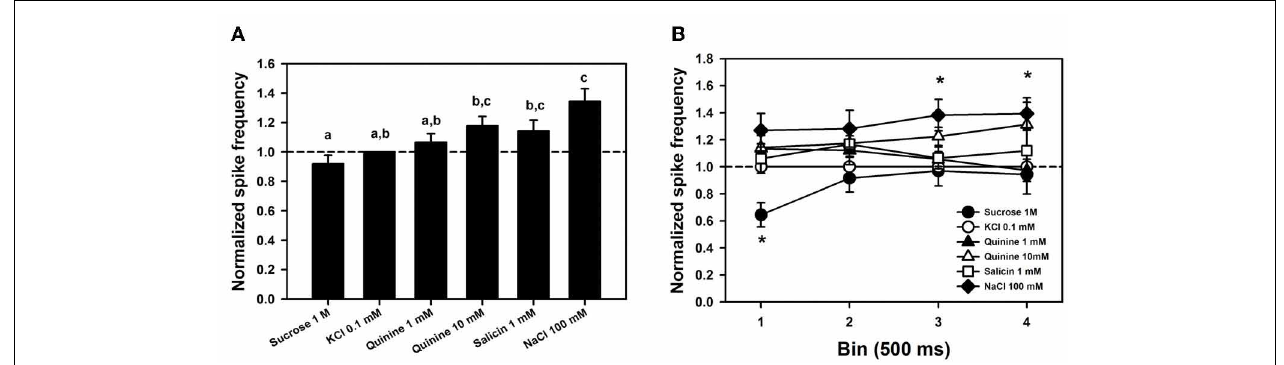
FIGURE 6 | (A) Mean normalized spike frequencies ( ± SE) obtained upon stimulation with the different tastants assayed. Responses (action potentials per second) were normalized to those recorded for KCl 0.1mM (hatched horizontal line). Data were obtained from 6 bees in which responses for the six tastants assayed were recorded 4 times ( n = 144) in 7